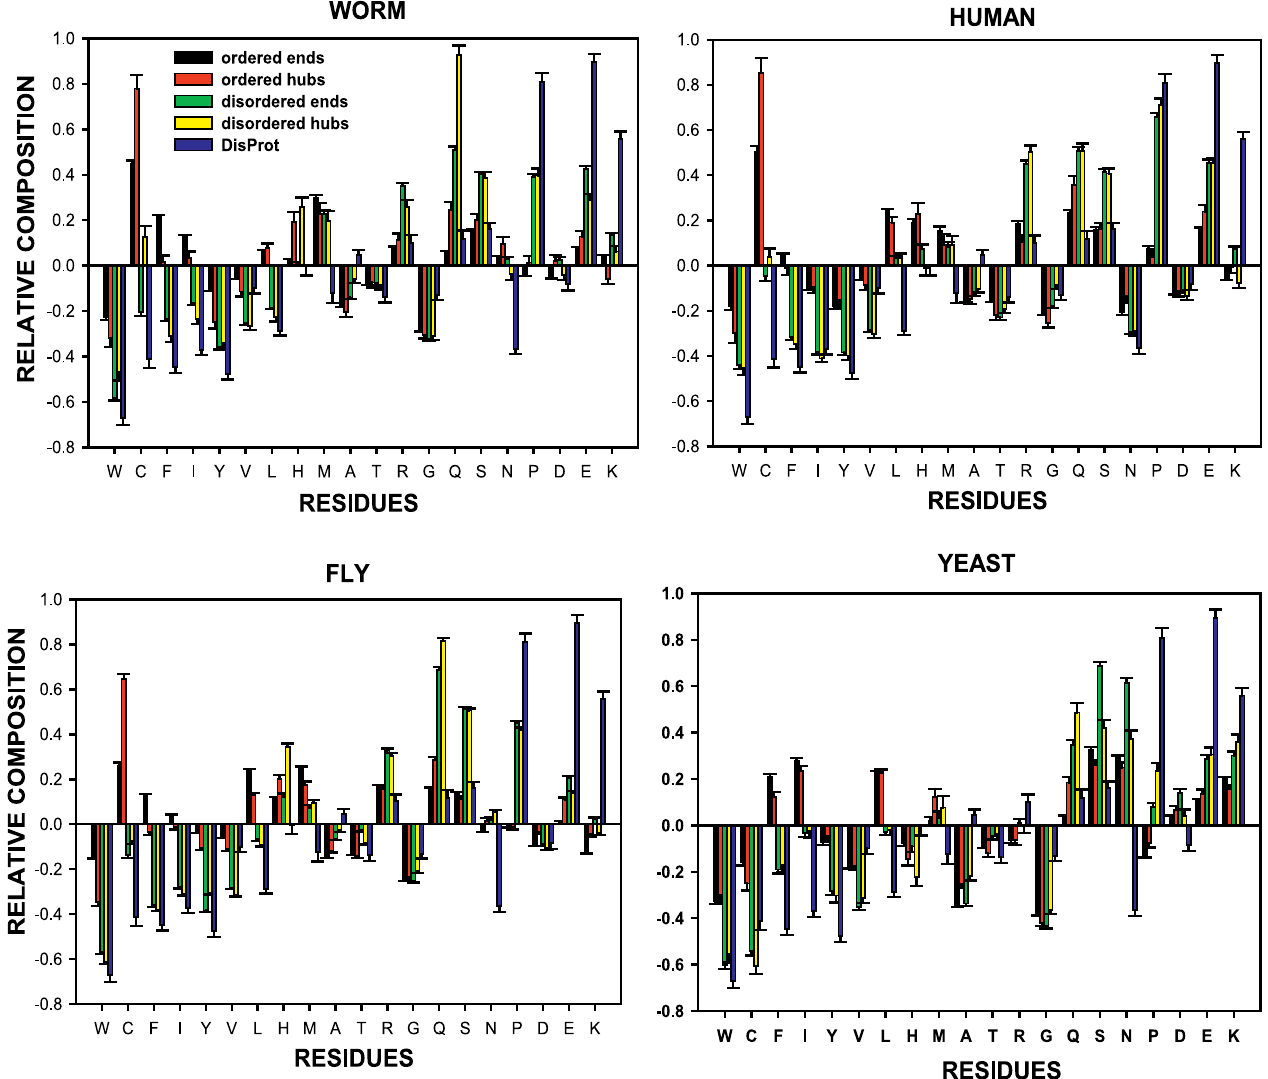
Figure 3. Amino Acid Compositions of Hub, End, and Disordered Proteins Are Shown Relative to the Composition of Completely Ordered Globular Proteins Amino acids are arranged from left to right in order of increasing flexibility as defined by Vihinen et al. [52]. The error bars were calculated as explained in Materials and Methods. DOI: